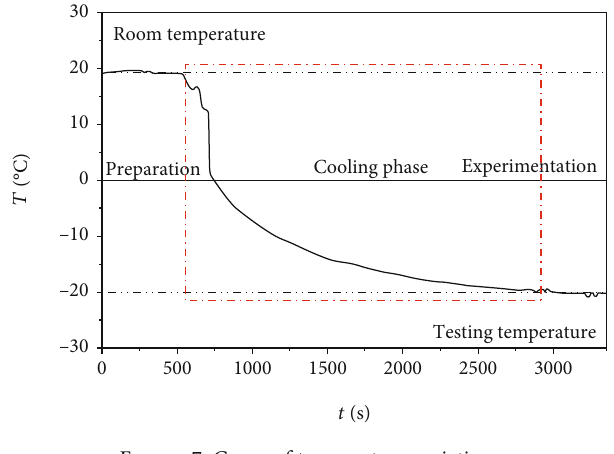
Figure 7: Curve of temperature variation.